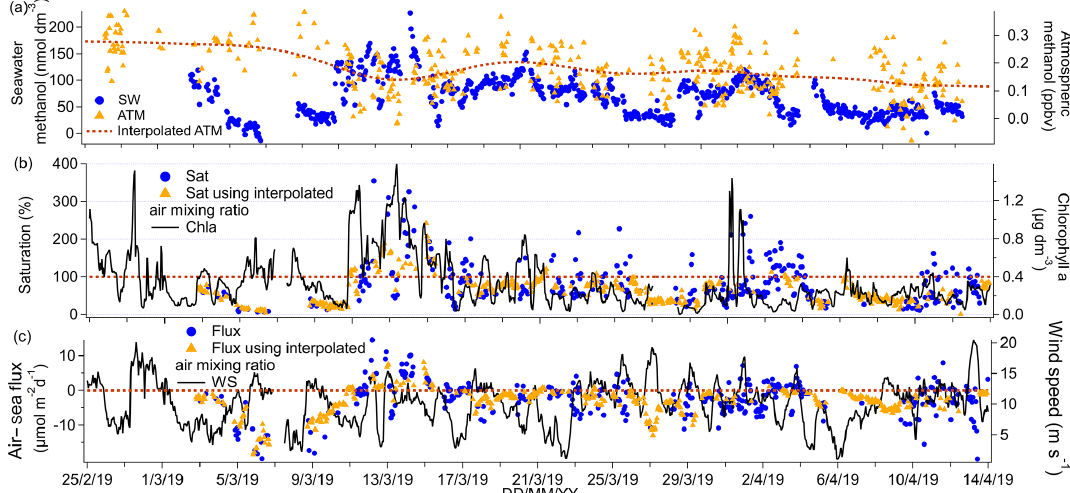
Figure 6. (a) Time series of methanol seawater (SW) concentrations as well as measured and interpolated marine boundary layer air mixing ratios (ATM and interpolated ATM). (b) Time series of methanol saturations determined using the measured air mixing ratio and interpolated air mixing ratio and time series of chlorophyll a . (c) Time series of air–sea methanol fluxes calculated using the measured air mixing ratio and interpolated air mixing ratio and time series of wind speed.